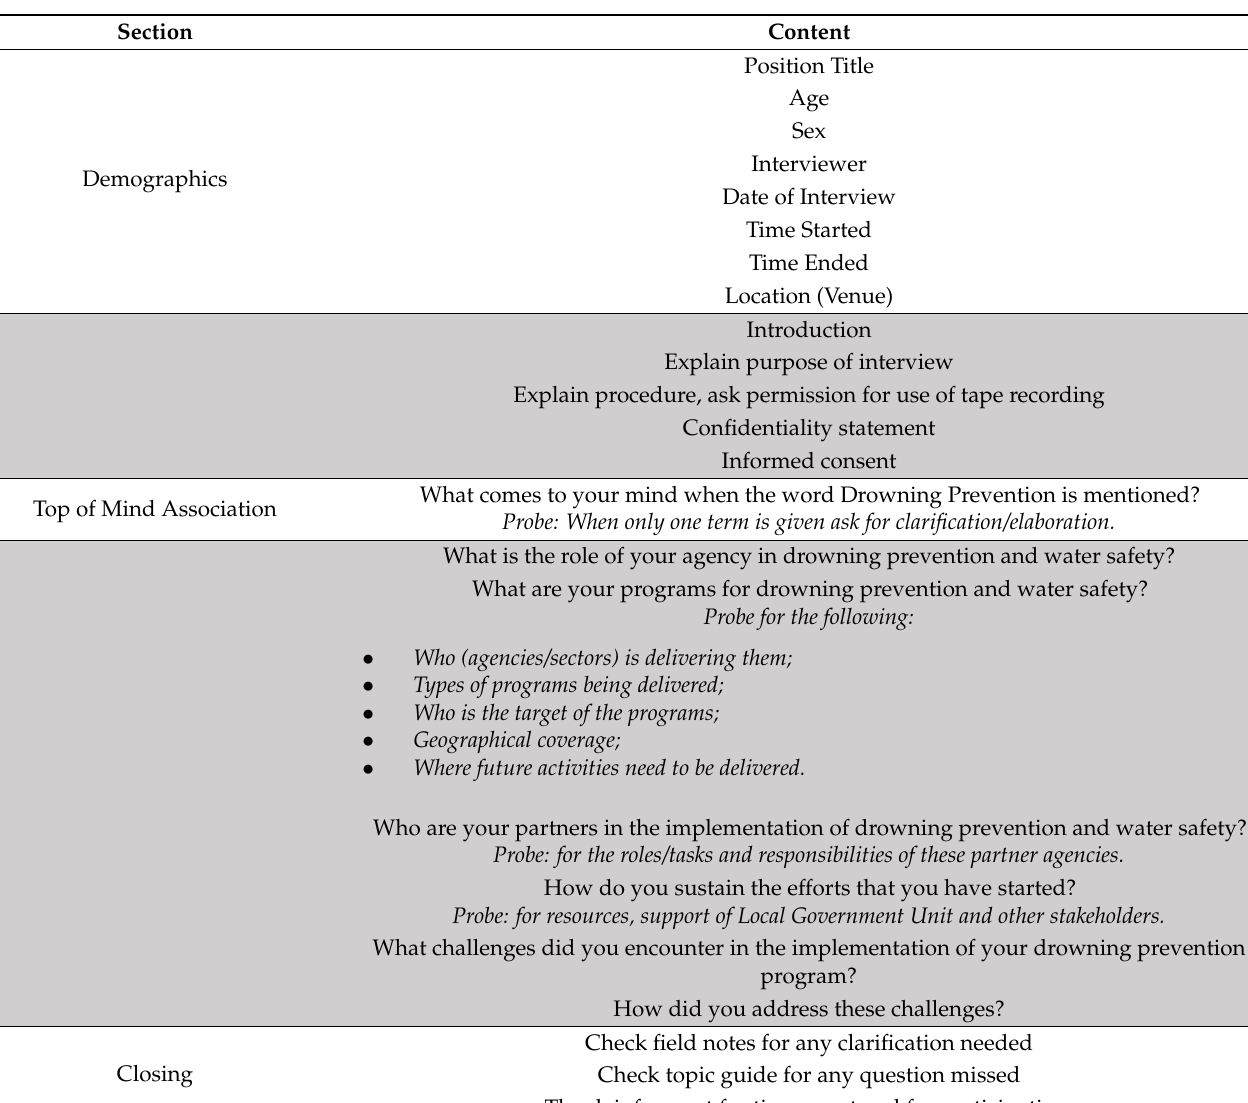
Table 1. Key Informant Interview